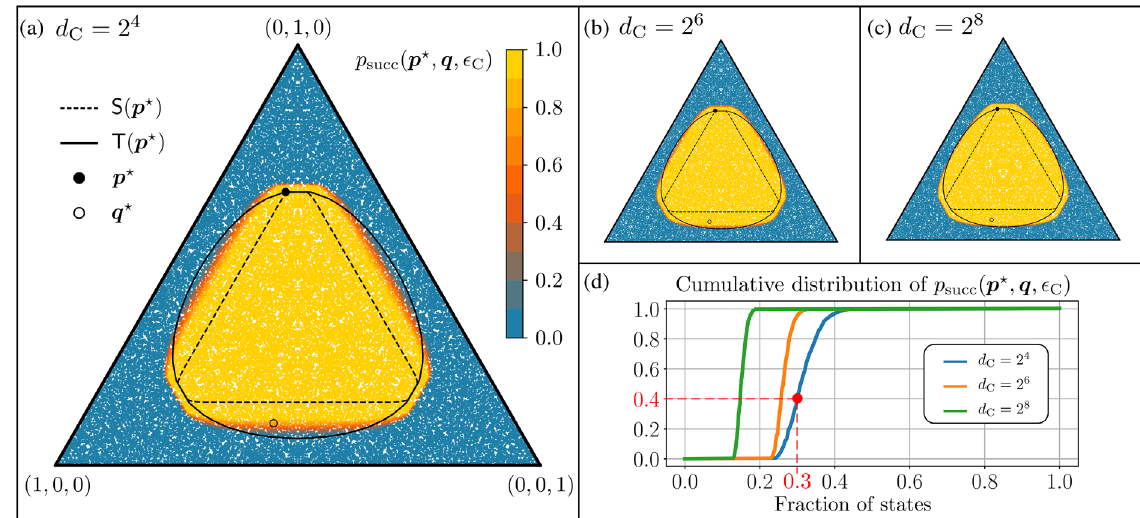
p ⋆ ; q ; ϵ FIG. 4. Probability p that a random state can be used to enable the transformation from p ⋆ to q approximately succ ð C Þ μϵ bnd catalytically, i.e., with an error ϵ and μ ¼ 0 . 1 . Plots (a) – (c) correspond to different dimensions of the random catalyst C ¼ C 2 4 , 2 6 , and 2 8 , respectively). States inside the region bounded by dashed lines define the thermal set S ð p ⋆ Þ , consisting of all states ( d C ¼ that can be reached from p ⋆ using thermal operations. The solid line corresponds to the catalytic-thermal set T ð p ⋆ Þ , consisting of all states that can be reached from p ⋆ with the help of some (potentially finely tuned) catalyst. Note that the probability of success p ⋆ ; q ; ϵ p is generally very close to 1 for most final states q inside D ð p ⋆ Þ ≔ T ð p ⋆ Þn S ð p ⋆ Þ , even when the dimension of the catalyst succ ð C Þ p ⋆ ; q ; ϵ is relatively small. Plot (d) illustrates the cumulative distribution of p . To simplify the interpretation, an exemplary point is succ ð C Þ drawn in red. It corresponds to the case when 30% of all states q ∈ D ð p ⋆ Þ can be reached using random catalysts of dimension d with probability less than 0.4. In other words, 70% of all possible catalytic transformations can be realized using random catalysts with probability 0.4 or